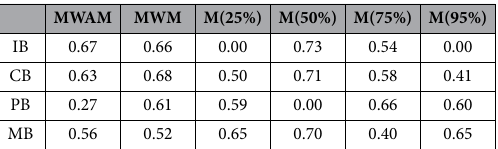
Table 2. Pagel’s λ of the four biting cases calculated for the variables: MWAM, MWM, M(25%), M(50%), M(75%) and M(95%).